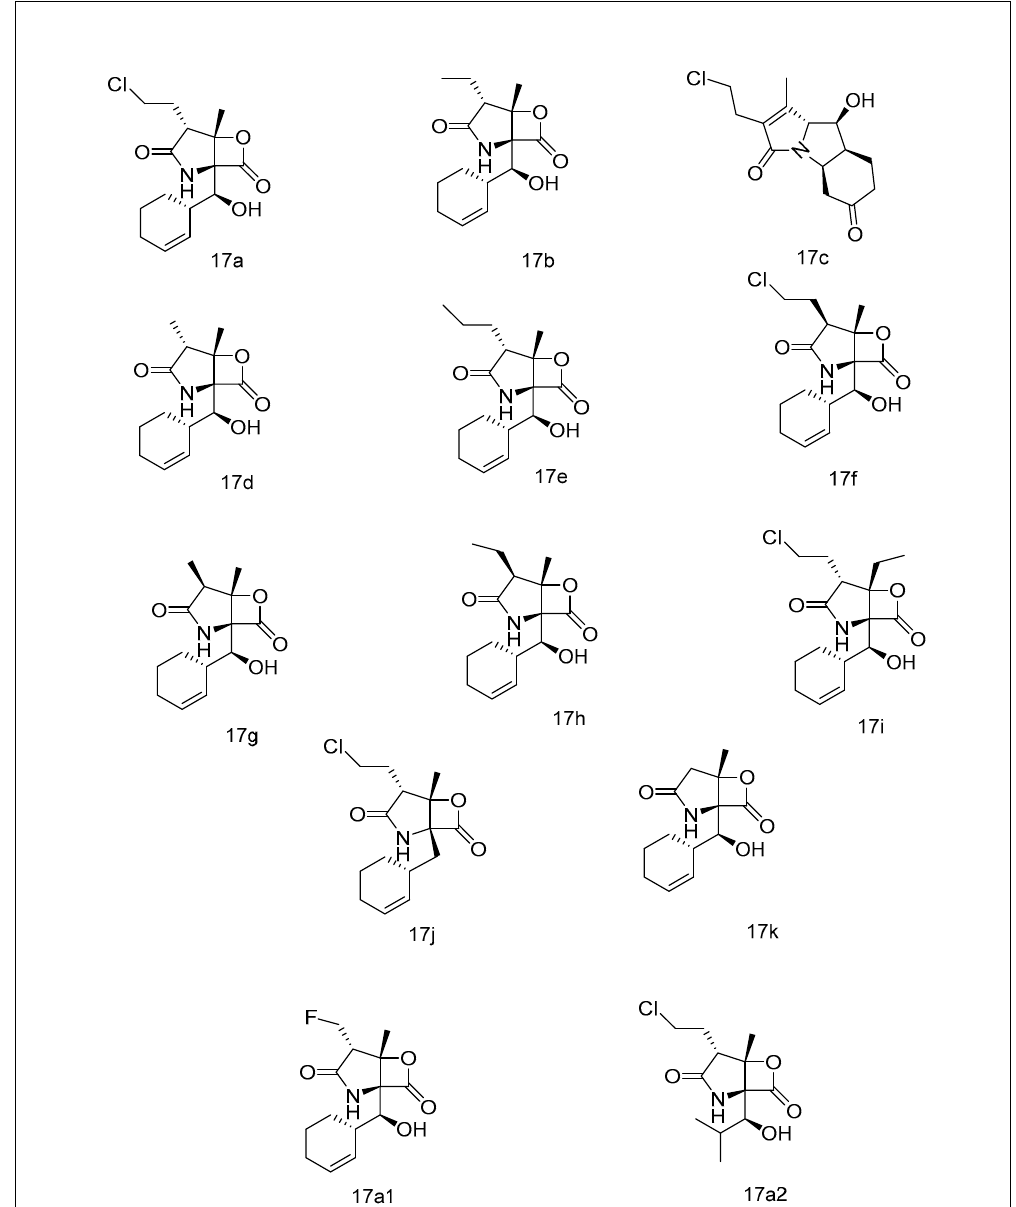
Figure 6. Salinosporamides with their structural counterparts: ( 17a ) salinosporamide A; ( 17b ) salinosporamide B; ( 17c ) salinosporamide C; ( 17d ) salinosporamide D; ( 17e ) salinosporamide E; ( 17f ) salinosporamide F; ( 17g ) salinosporamide G; ( 17h ) salinosporamide H; ( 17i ) salinosporamide I; ( 17j ) salinosporamide J; ( 17k ) salinosporamide K; ( 17a1 ) fluorosalinosporamide; ( 17a2 ) antiprotealide.